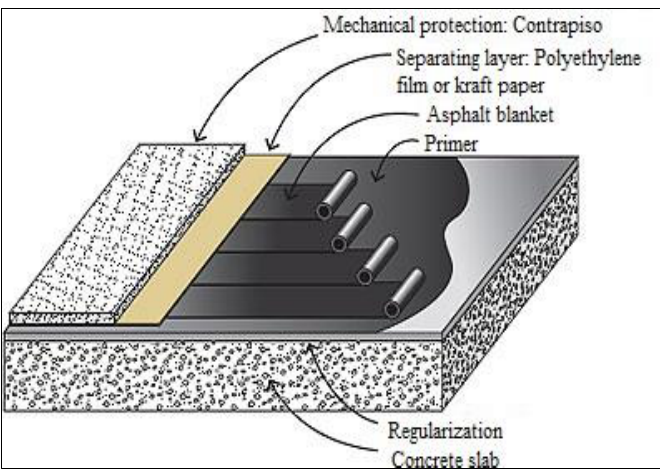
Figure 3: Waterproofing of asphalt blanket on a